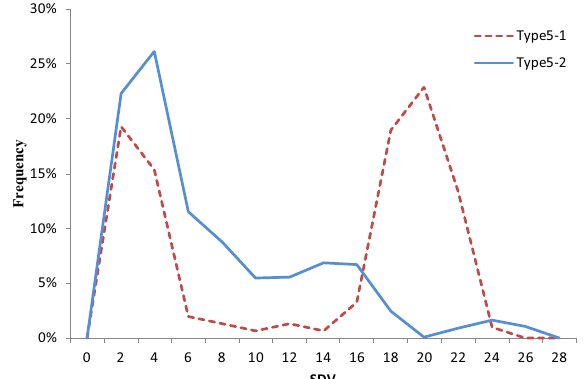
Figure 6. SDV of two homozygotes deviated from 1:1 in type 5-1 and 5-2 markers. Abscissa shows extent of SDVs (deviated from 1:1 of two homozygotes) of these markers. Ordinate indicates the frequency of markers fallen into each section and are shown as polyline. Imaginary line represents type 5-1 markers and solid line represents type 5-2 markers. Deviation between two homozygotes are more serious in 5-1 type